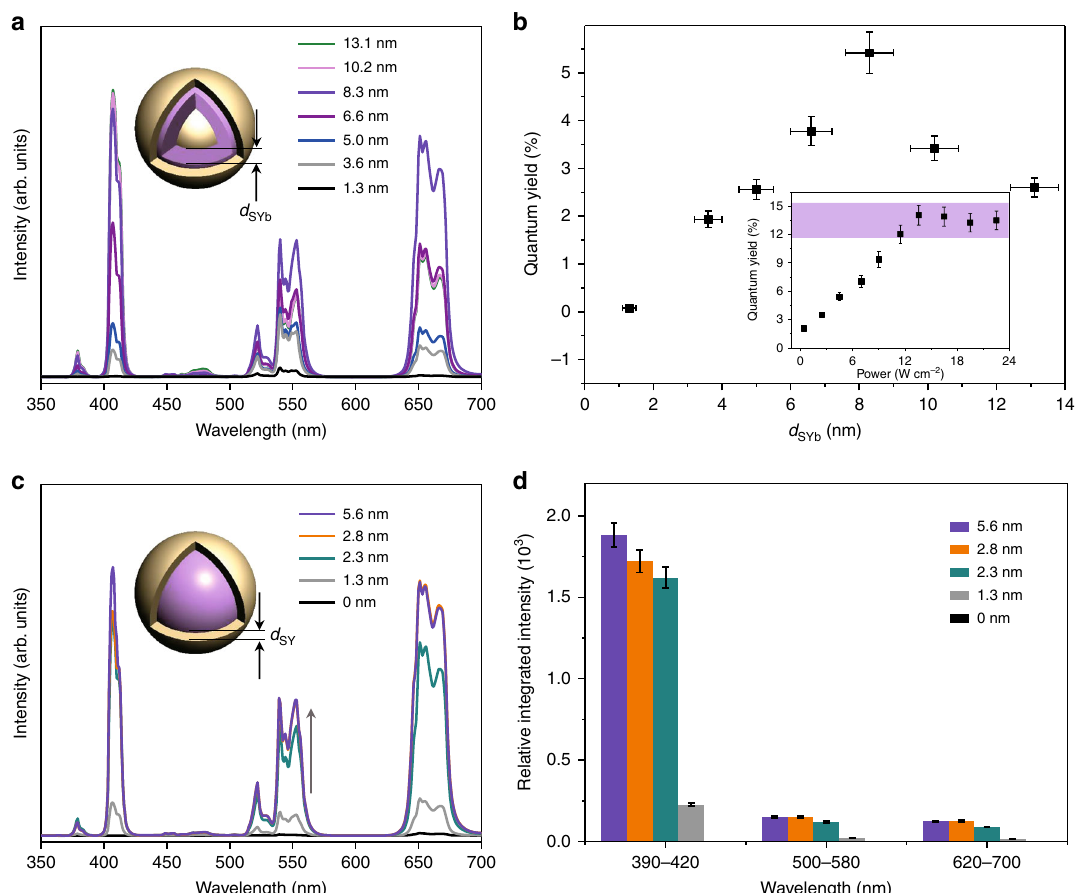
Fig. 3 Shell thickness-dependent upconversion luminescence. a , c Upconversion emission spectra for the C Y :10% Er@S Yb @S Y core-shell-shell nanoparticles with varying shell thickness: a NaYbF 4 shell, d SY = 2.0 – 2.7 nm; c NaYF 4 inert shell, d SYb = 8.3 ± 0.7 nm (collected with the mode of “ emission correction off ” ). b The quantum yields (QY) as a function of NaYbF 4 shell thickness (4.5 W cm − 2 ). The inset: power-dependent quantum yields for NPs with d SYb of 8.3 ± 0.7 nm and d SY of 2.3 ± 0.1 nm. The error bars for QY represent the standard deviation of three trials. Source data are provided as a Source Data fi le. The violet shading in the inset is used to mark saturated QY. d Corresponding emission intensity for violet, green and red bands when the thickness of NaYF 4 shell varies. The results indicate the key roles of excitation energy enrichment and inert shell protection in enhancement of multiphoton upconversion for the core – shell – shell nanoparticles. The standard deviation of three trials are shown as error bars. Source data are provided as a Source Data fi